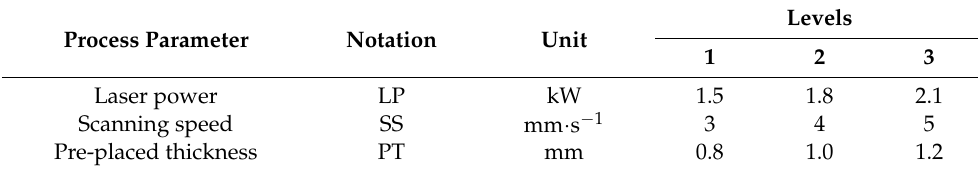
Table 4. Parameter variables of laser